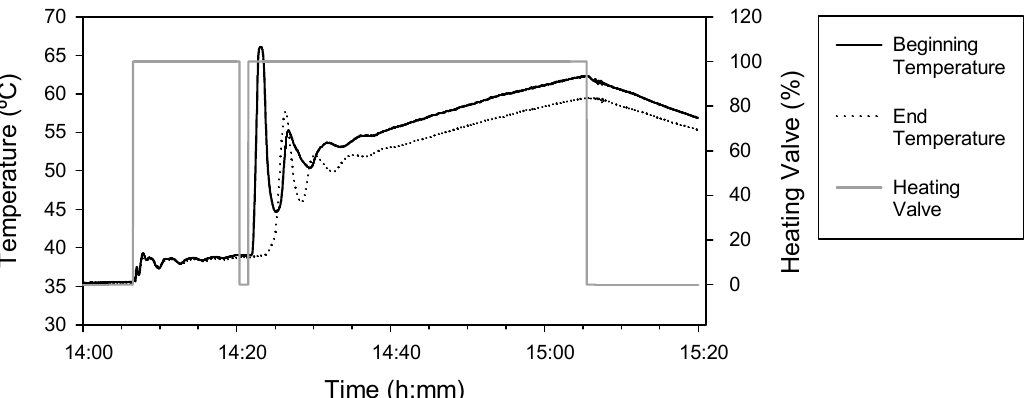
ronment, and the temperature at the beginning of the water circuit.